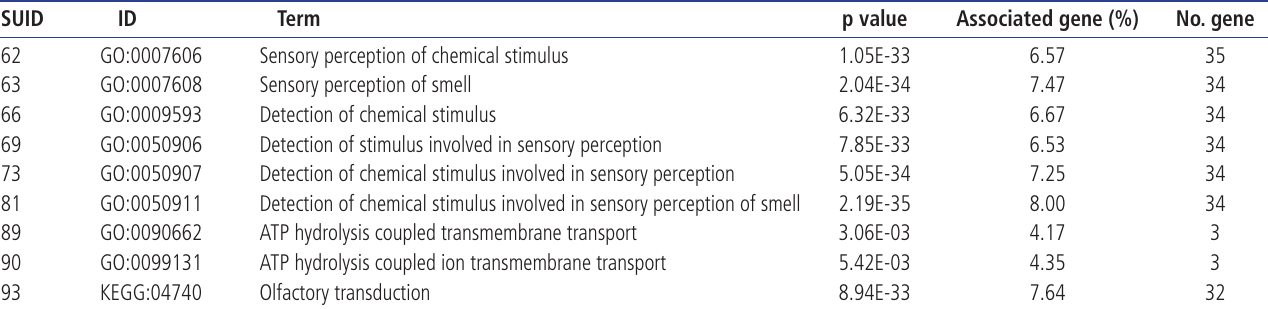
Table 2. Go ontology (GO) and Kyoto encyclopedia of genes and genomes (KEGG) pathway analyses of genes in the identified copy number variation regions